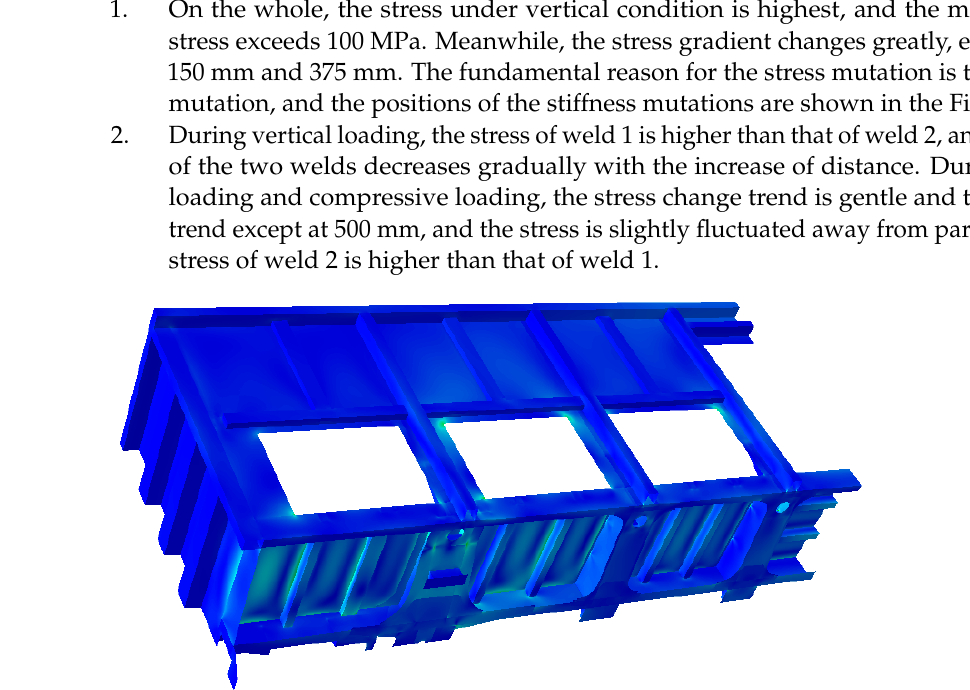
Figure 6. The finite element simulation results under vertical loading.